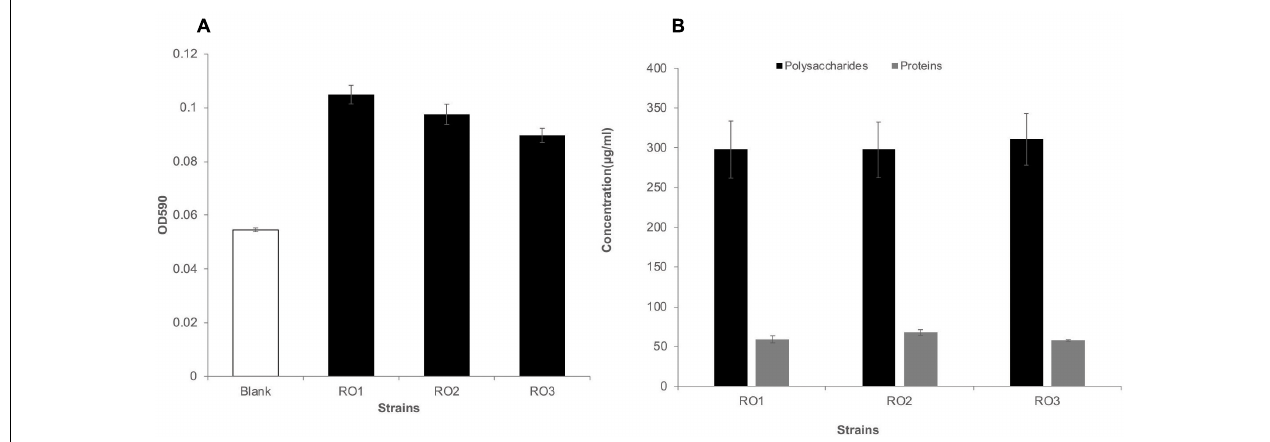
FIGURE 2 | Biofilm formation and EPS production by RO isolates. Biofilm formation by the RO membrane isolates (RO1, RO2, and RO3) on polystyrene surface after 48 h, given as optical density at 590 nm ( y -axis) (A) . Blank represents marine broth without inoculation. The height of bars shows the average of three biological replicates, while error bars represent standard deviation. Student’s t -test showed no significant difference in biofilm formation by the three isolates ( p > 0.05). The amount of polysaccharides (black) and proteins (gray) produced by the RO isolates (RO1, RO2, and RO3) was similar (B) . The quantity of polysaccharide and proteins is given as µ g/ml of culture media along the y -axis. The height of bars shows the average of three independent measurements, while error bars show standard deviation. The amount of polysaccharides was approximately five times higher than the amount of